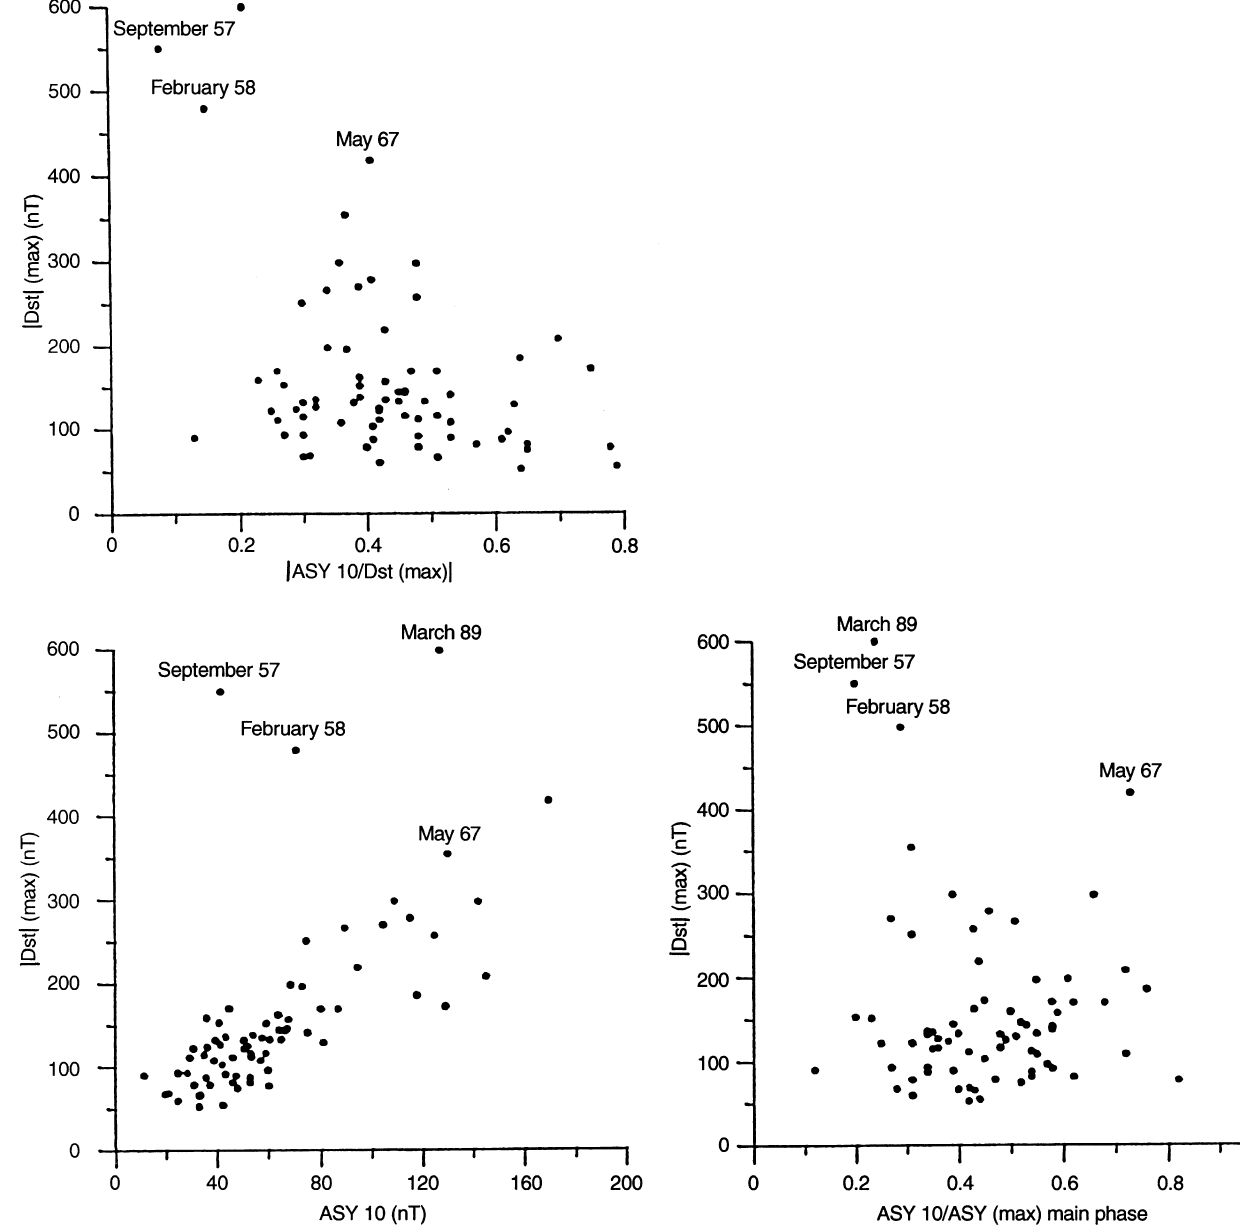
Fig. 6. Relationship between maximum j Dst j and the over 10 h averaged values of ASY after beginning of the recovery phase (1989–1995 and some very